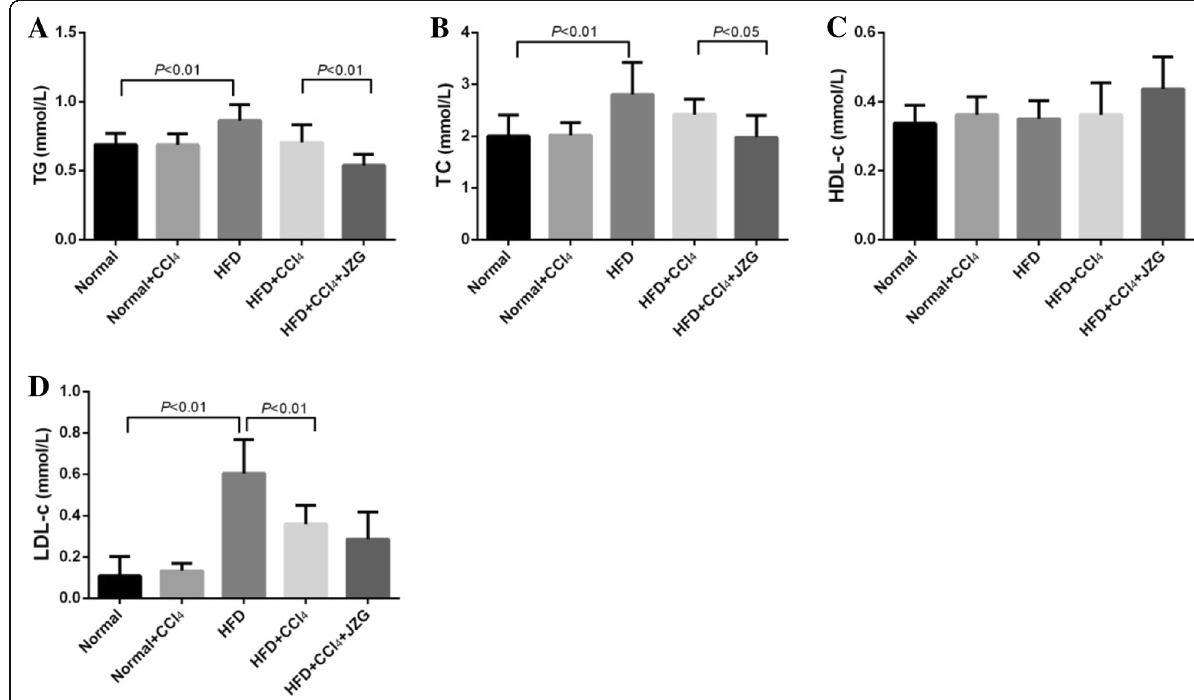
Fig. 5 Effect of JZG on serum lipids: a The serum TG level, b The serum TC level, c The serum HDL-c level, d The serum LDL-c level. The values represent the mean ± SD. ( N = 8 per